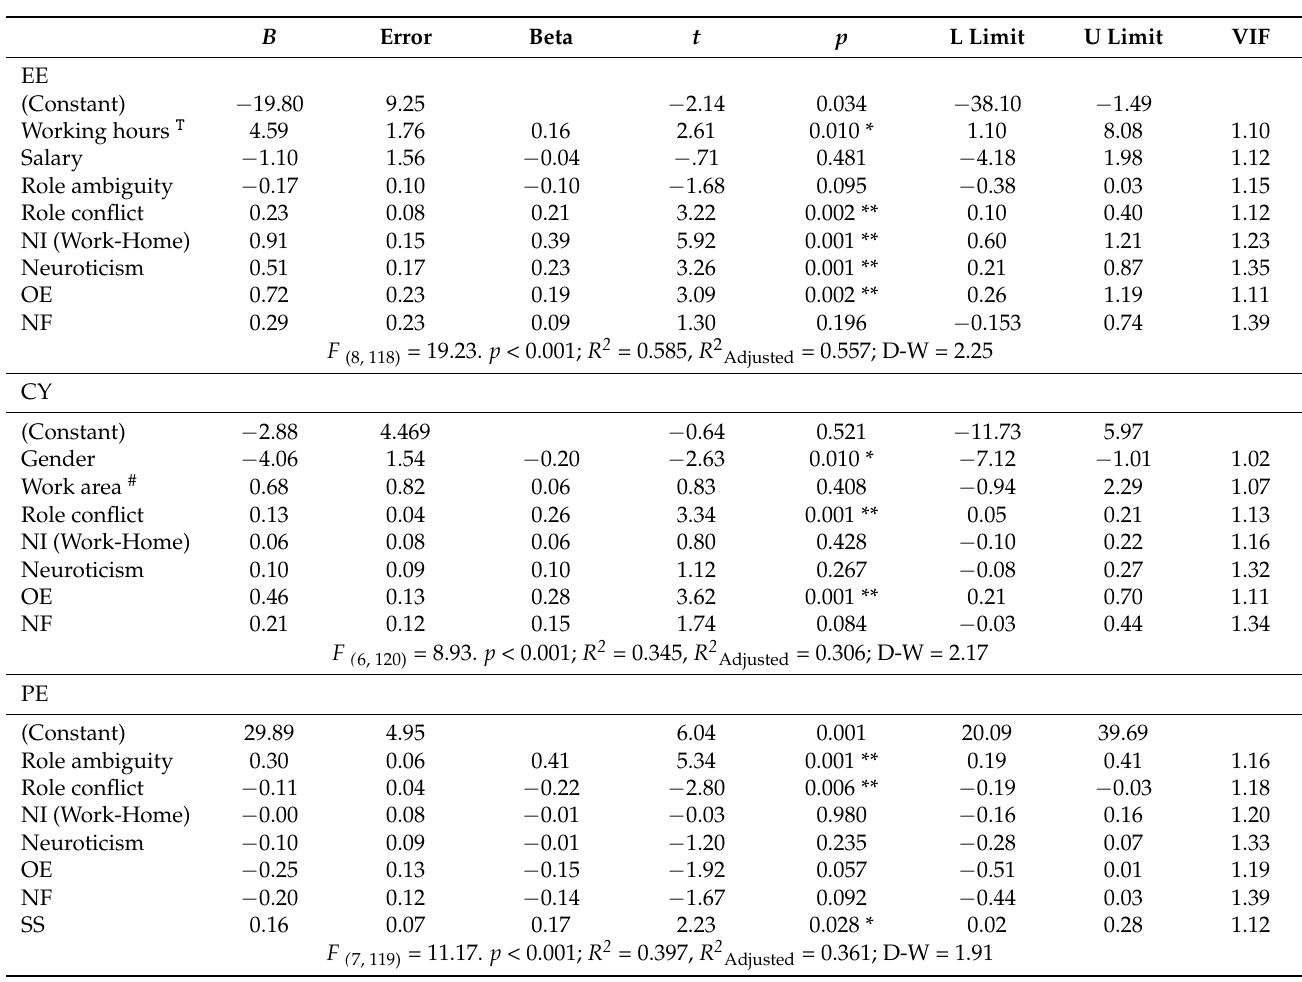
Table 3. Multiple regression models of burnout